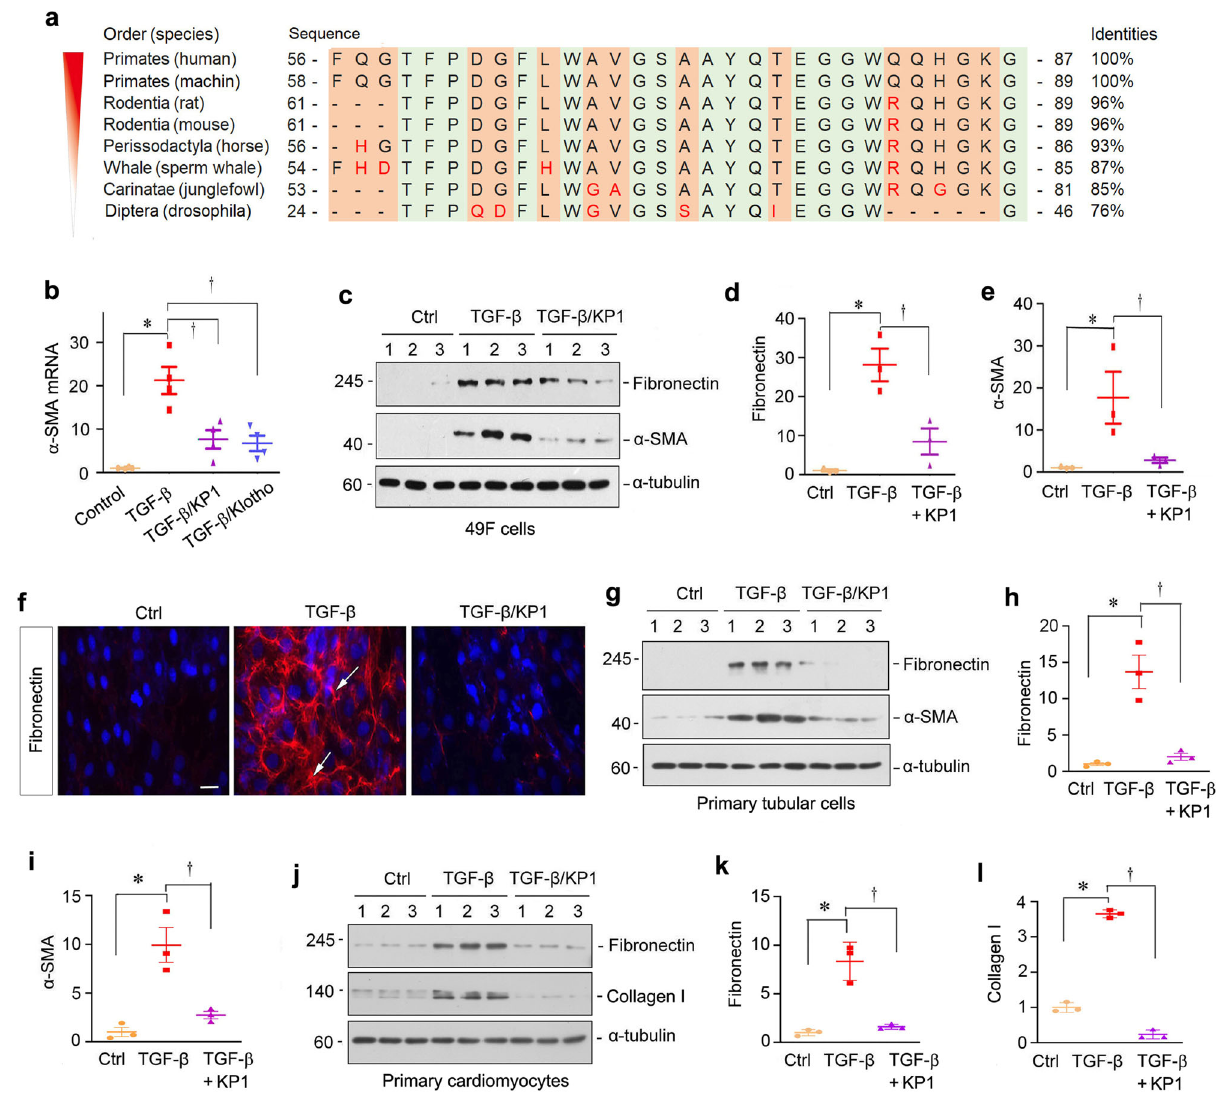
Fig. 1 Identi fi cation of a Klotho-derived peptide (KP1) that inhibits TGF- β 1 action in vitro. a Amino acid sequence alignment of KP1 in various species. A light green background indicates the regions with identical amino acids in different species. Differences in amino acids among various species are highlighted by red color. b KP1 inhibited the induction of α -SMA mRNA by TGF- β 1 in NRK-49F cells. NRK-49F cells were incubated with TGF- β 1 (2 ng/ml) in the absence or presence of KP1 (10 µ g/ml) or sKlotho (10 µ g/ml). The expression of α -SMA mRNA was assessed by qRT-PCR. P values (from left to right): <0.001, 0.001, <0.001. n = 4 biologically independent cells. c – e KP1 inhibited the protein expression of fi bronectin and α -SMA. NRK-49F cells were preincubated with KP1 (10 µ g/ml; 3 µ M) for 1 h and then treated with TGF- β 1 (2 ng/ml) for 24 h. Western blot ( c ) and quantitative data ( d , e ) are presented. P values (from left to right): 0.001 and 0.004 ( fi bronectin); 0.017 and 0.026 ( α -SMA). n = 3 biologically independent cells. f KP1 inhibited TGF- β 1-mediated fi bronectin expression and deposition by NRK-49F cells. Representative micrographs with immuno fl uorescence staining of fi bronectin are shown. Scale bar, 50 µ m. Arrows indicated positive staining. g – i KP1 inhibited the expression of fi bronectin and α -SMA in primary tubular cells. Western blot analyses ( g ) and quantitative data of fi bronectin ( h ) and α -SMA ( i ) are shown. P values (from left to right): 0.001 and 0.001 ( fi bronectin); 0.001 and 0.003 ( α -SMA). n = 3 biologically independent cells. j – l The protein level of fi bronectin and collagen I expressed by primary cardiomyocytes. Western blot analyses ( j ) and quantitative data of fi bronectin ( k ) and collagen I ( l ) are shown. P values (from left to right):0.001 and 0.001 ( fi bronectin); <0.001 and <0.001 (collagen I). n = 3 biologically independent cells. Ctrl controls. Data are presented as mean values ± SEM. Statistical signi fi cance was determined by one-way ANOVA followed by Fisher ’ s Least-signi fi cant Difference (LSD) post hoc test. Source data are provided as a Source Data fi